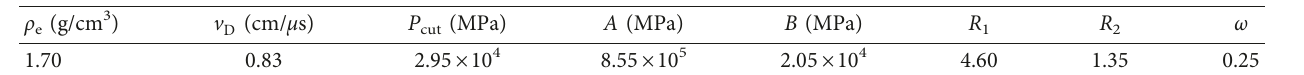
Table 5: Parameters of explosive and its EOS equation.